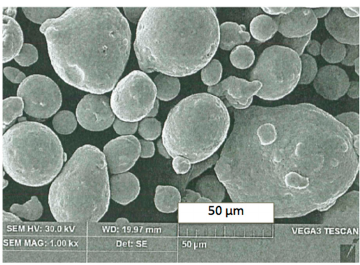
Figure 3. SEM image of the powdered steel 1.2709.